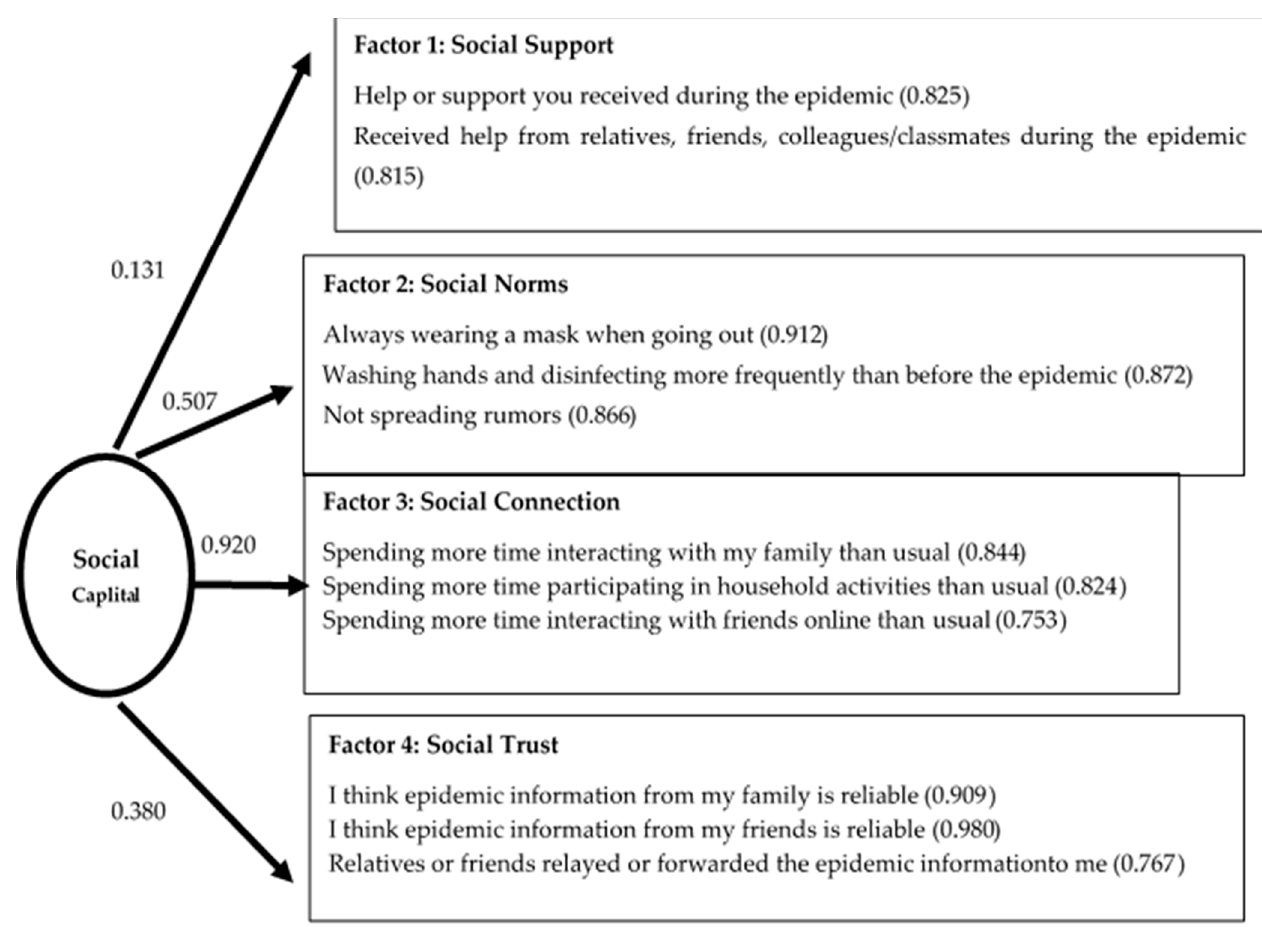
Figure 1. Factor analysis results for social capital.